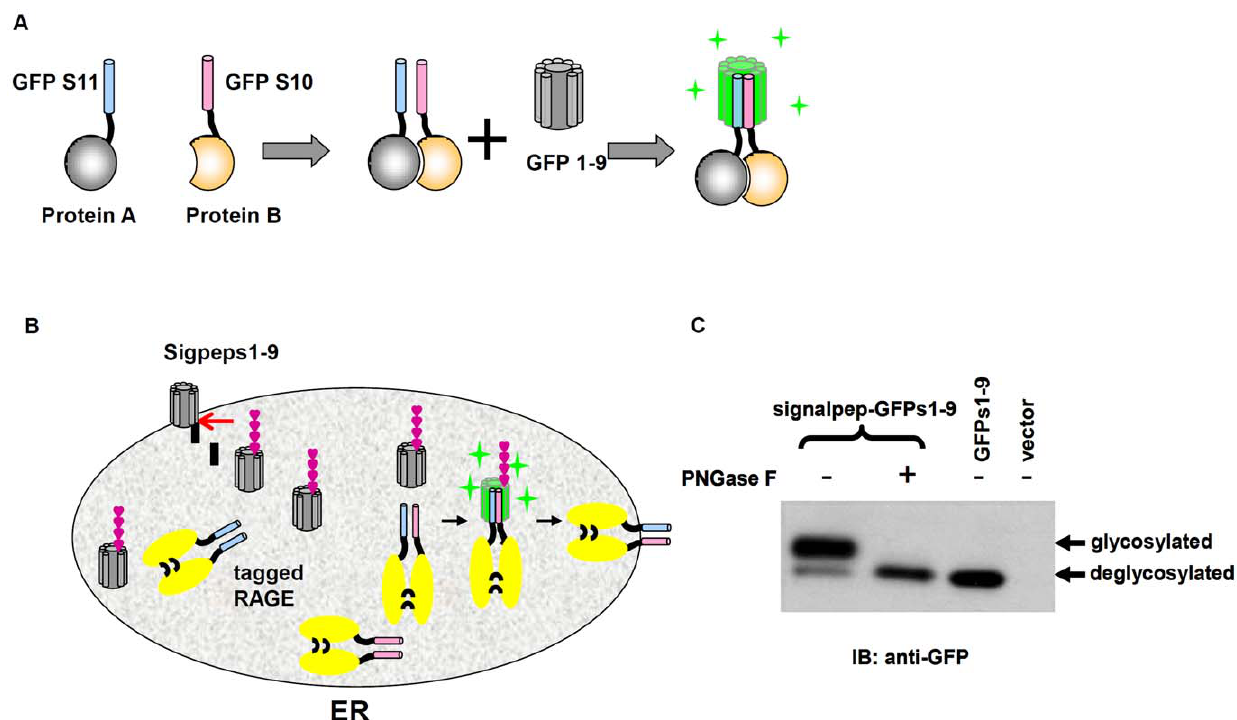
Figure 6. Design of tripartite split GFP complementation to study RAGE dimerization in the ER. ( A ) Illustration of general tripartite split GFP complementation strategy. GFP s10 and s11 are used to tag test proteins whereas GFPs1-9 functions as a detector. When tagged test proteins interact with each other to bring s10 and s11 sufficiently close that they interact with s1-9 to generate green fluorescence. ( B ) Illustration of tripartite split GFP complementation to detect RAGE dimerization in the ER. GFPs1-9 is targeted to the ER with RAGE signal peptide (black bar). Upon entering the ER, the signal peptide is cleaved and GFPs1-9 is glycosylated (magenta chain), and complementation occurs only when s10 and s11-tagged RAGE molecules dimerise. Double disulfide bridge-linked RAGE dimers then leave the ER-Golgi for the cell surface. ( C ) Targeting GFPs1-9 to the ER. Glycosylation of GFPs1-9 confirms that GFPs1-9 is localized in the ER.